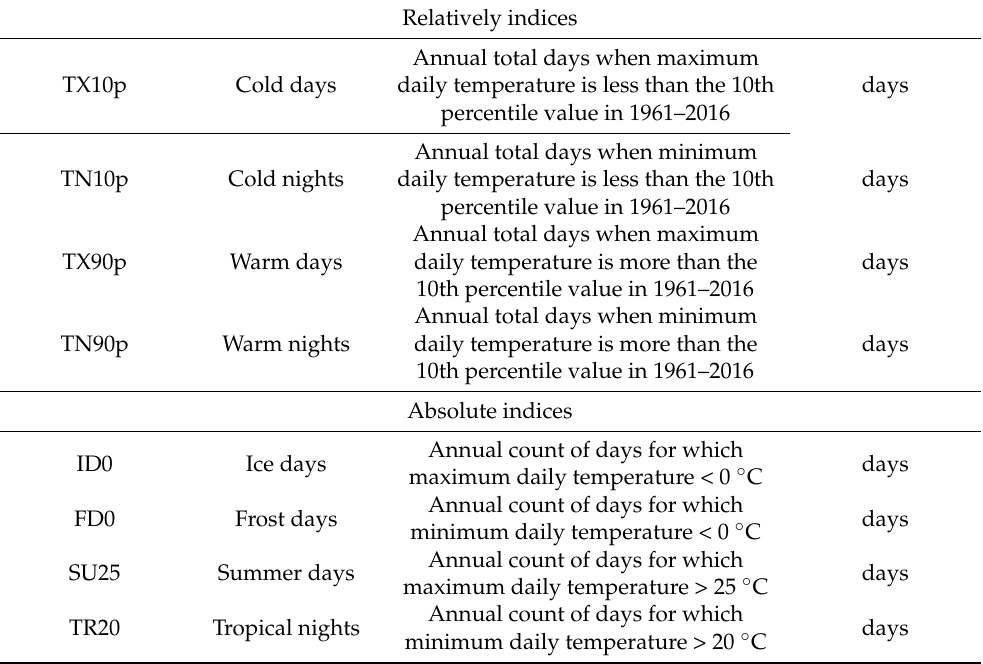
Table 1. Definitions of extreme temperature